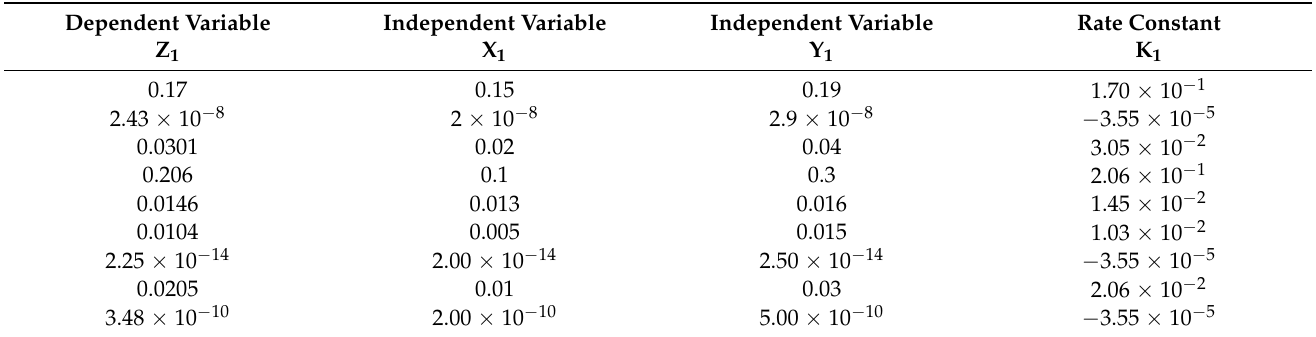
Table 2. The rate constant (K 1 ) was predicted using a dependent variable (Z 1 ), and independent variables X 1, and Y 1 with a difference of 0.02 in experimentally fixed value at 420 ◦ C.